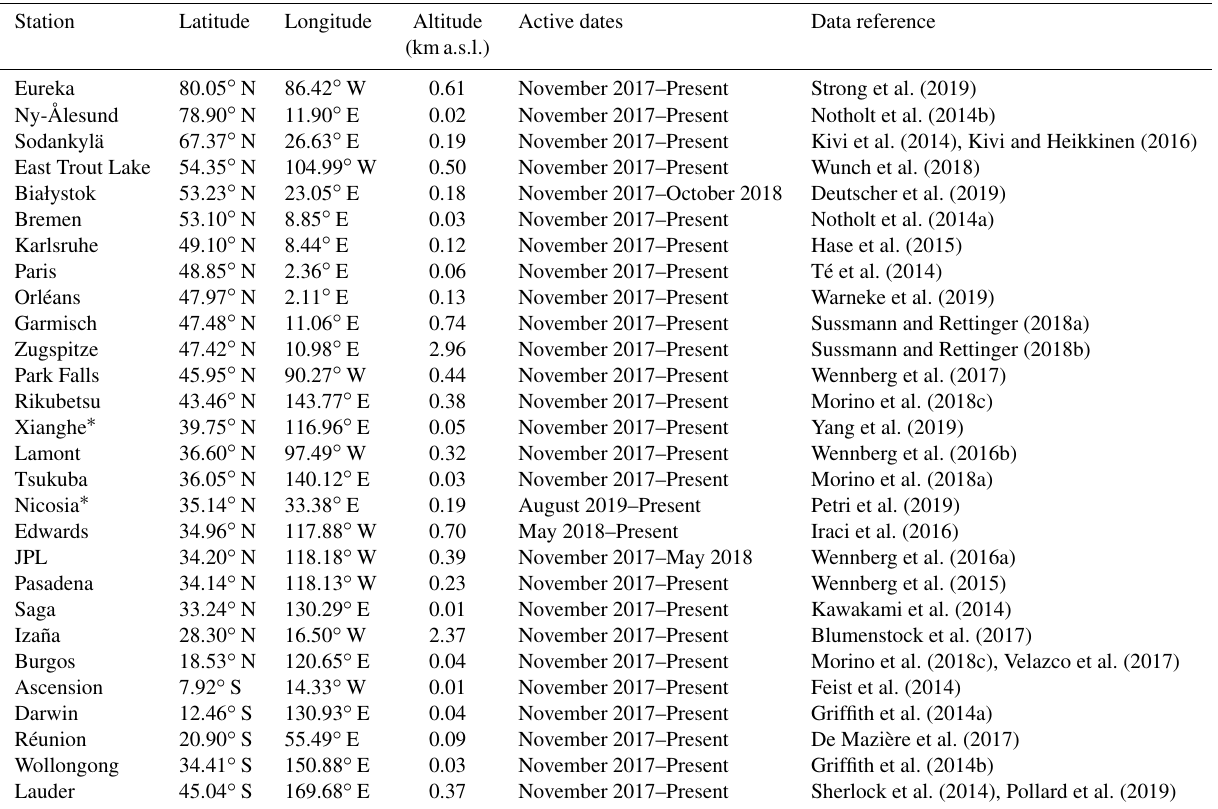
Table 2. List of FTIR stations that are associated with TCCON and contributed to the present work by providing public and rapid delivery data. The stations marked with an asterisk ( ∗ ) are not yet associated with TCCON but perform observations and data analysis fully compatible with TCCON guidelines. Active dates correspond to the dates for which the measurements were provided from the satellite launch until the present